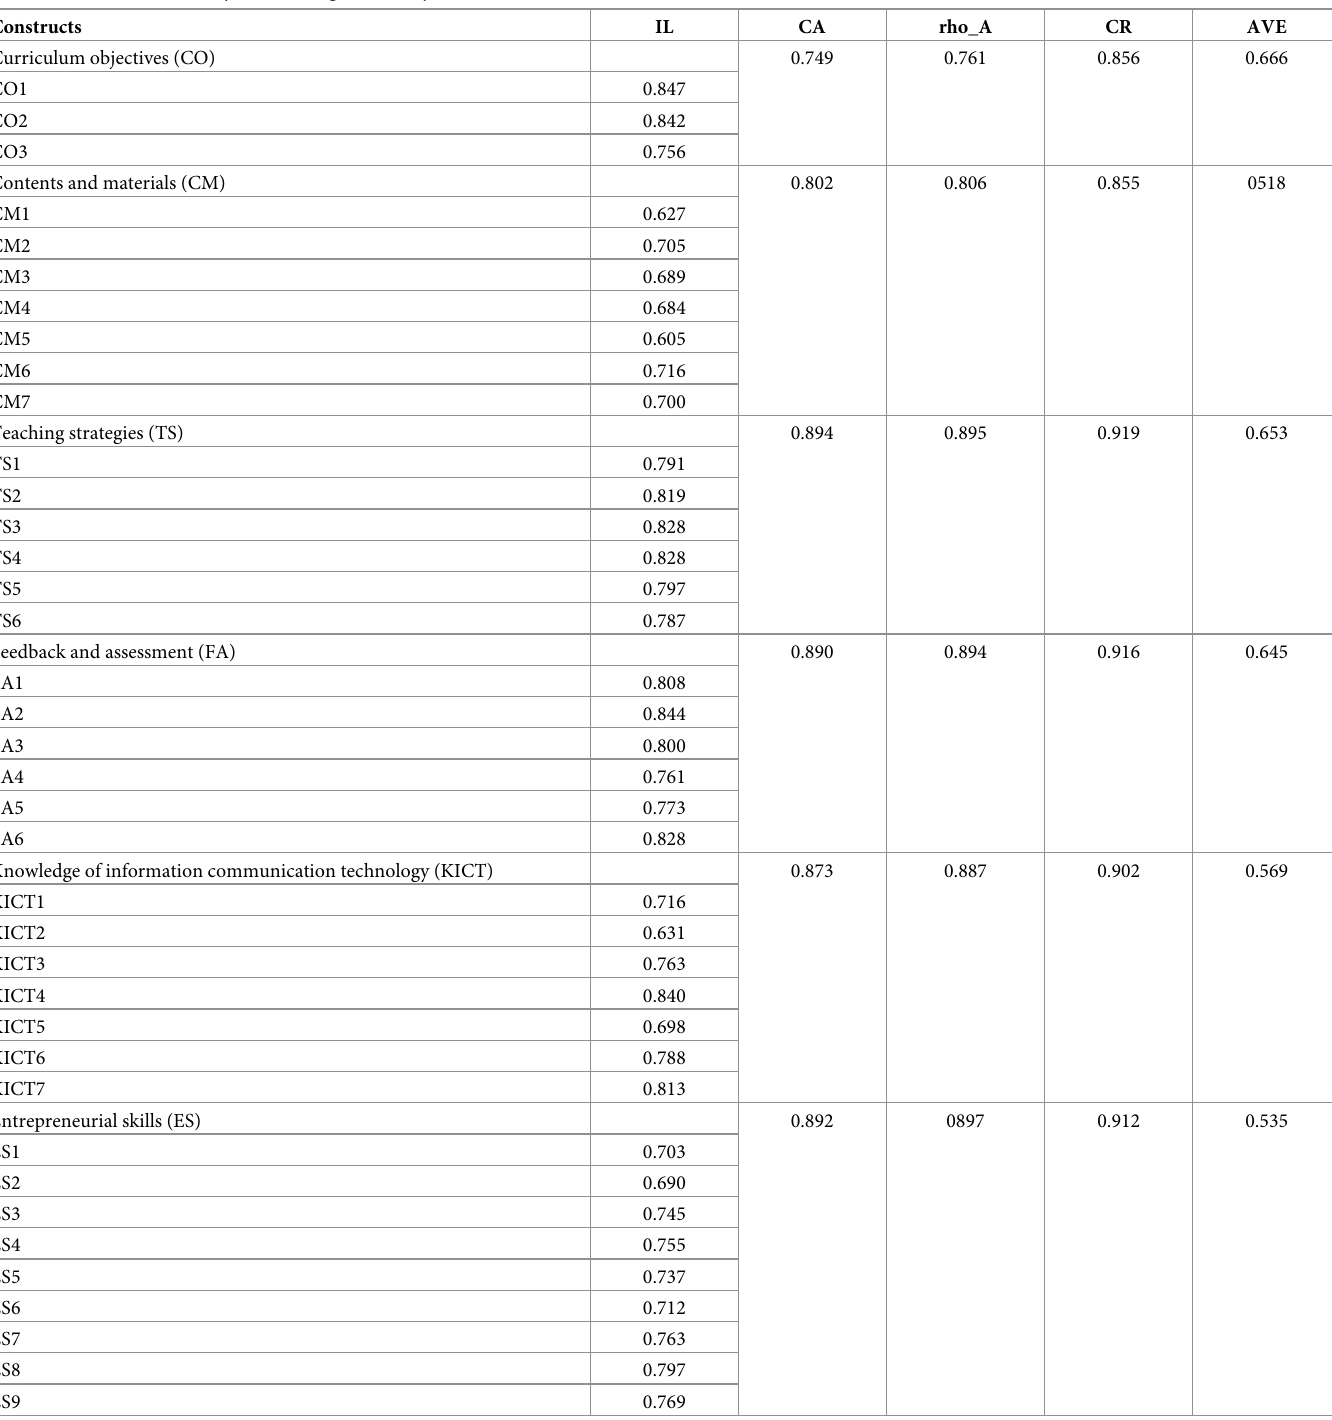
Table 2. Construct reliability and convergent